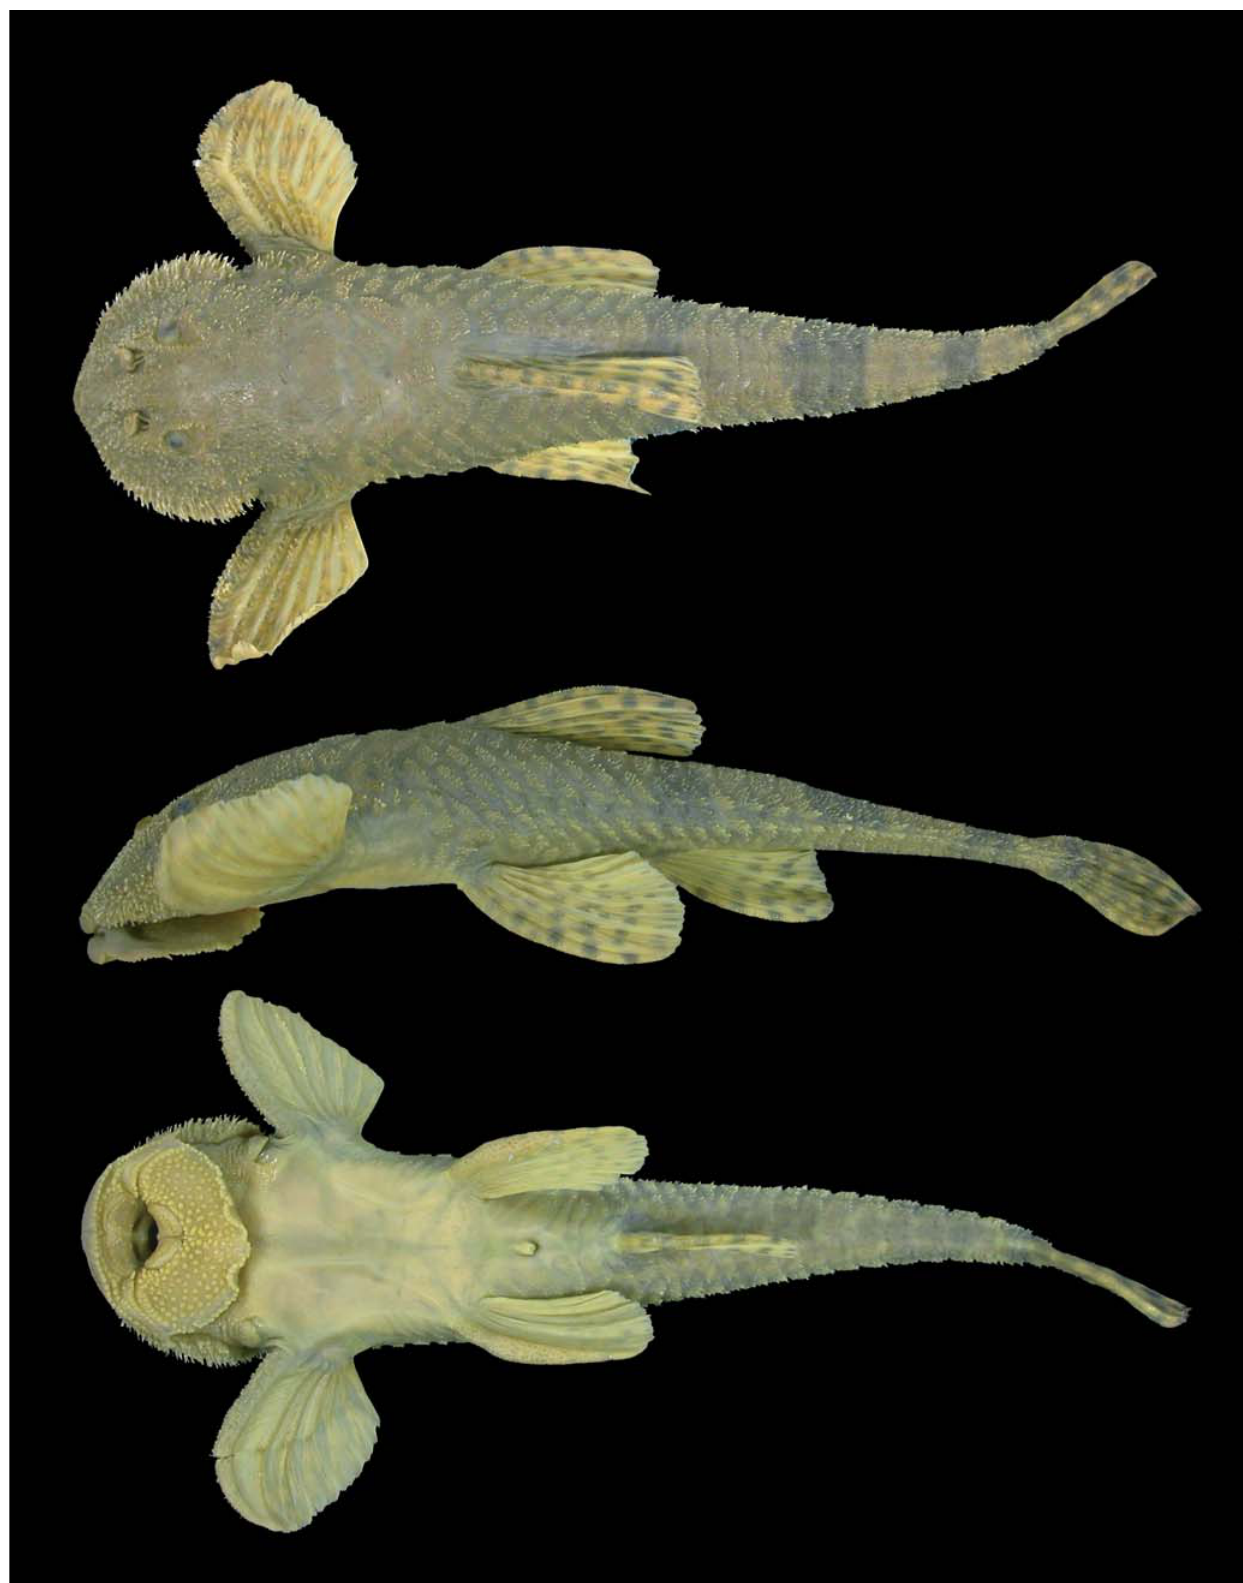
Fig. 5. Ixinandria steinbachi , UMSS 215, 100.3 mm SL, male, río Orosas, Aniceto Arce, Province of Tarija, río Bermejo basin,